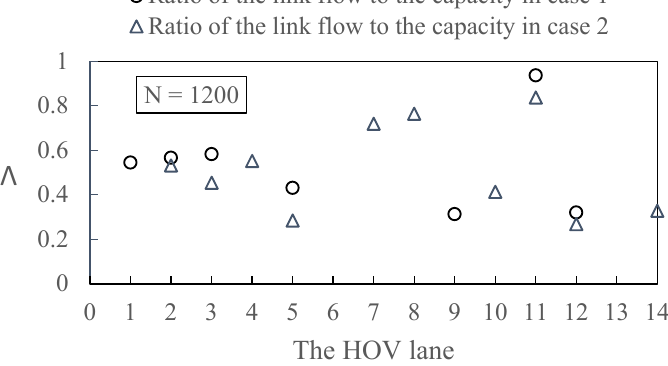
Figure 5. Ratio of the link flow to the capacity on the HOV links.